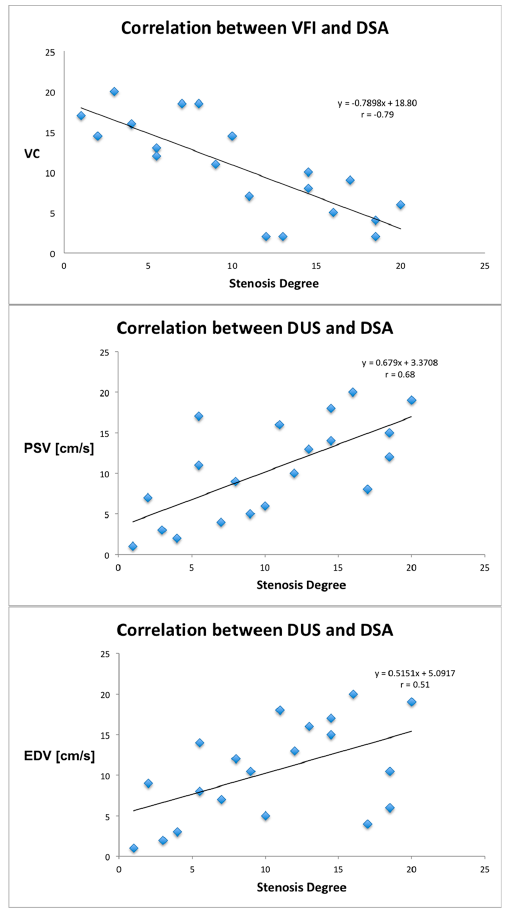
Figure 4. Scatterplots (spearman rank correlation) of VFI and DUS against DSA. The solid line in each plot indicates the line of best fit. plot indicates the line of best